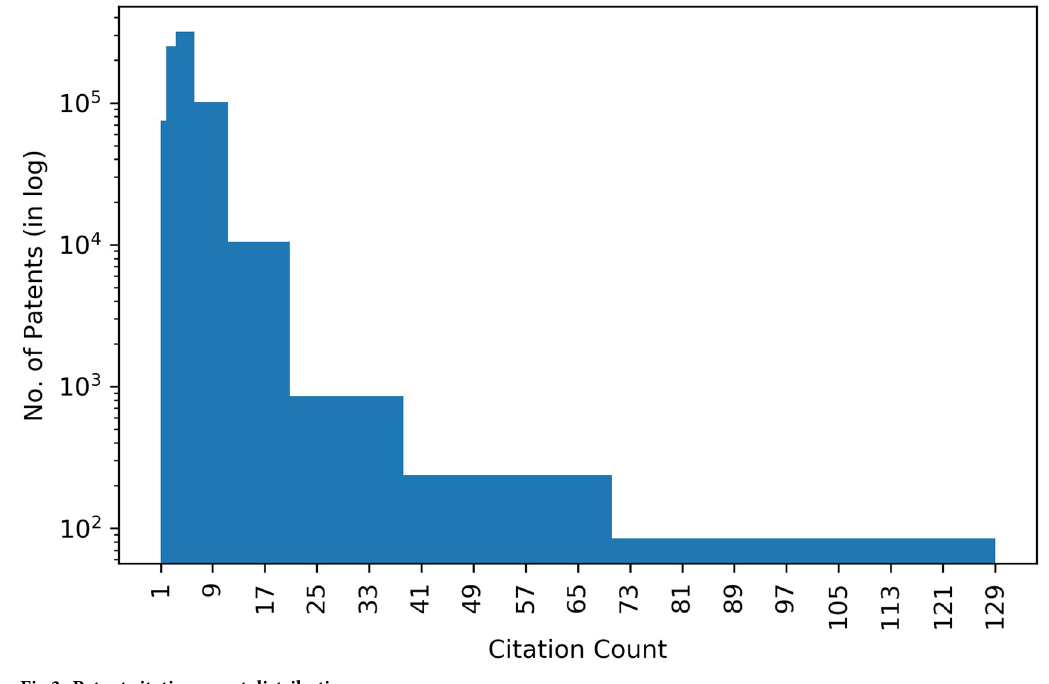
Fig 3. Patent citation count